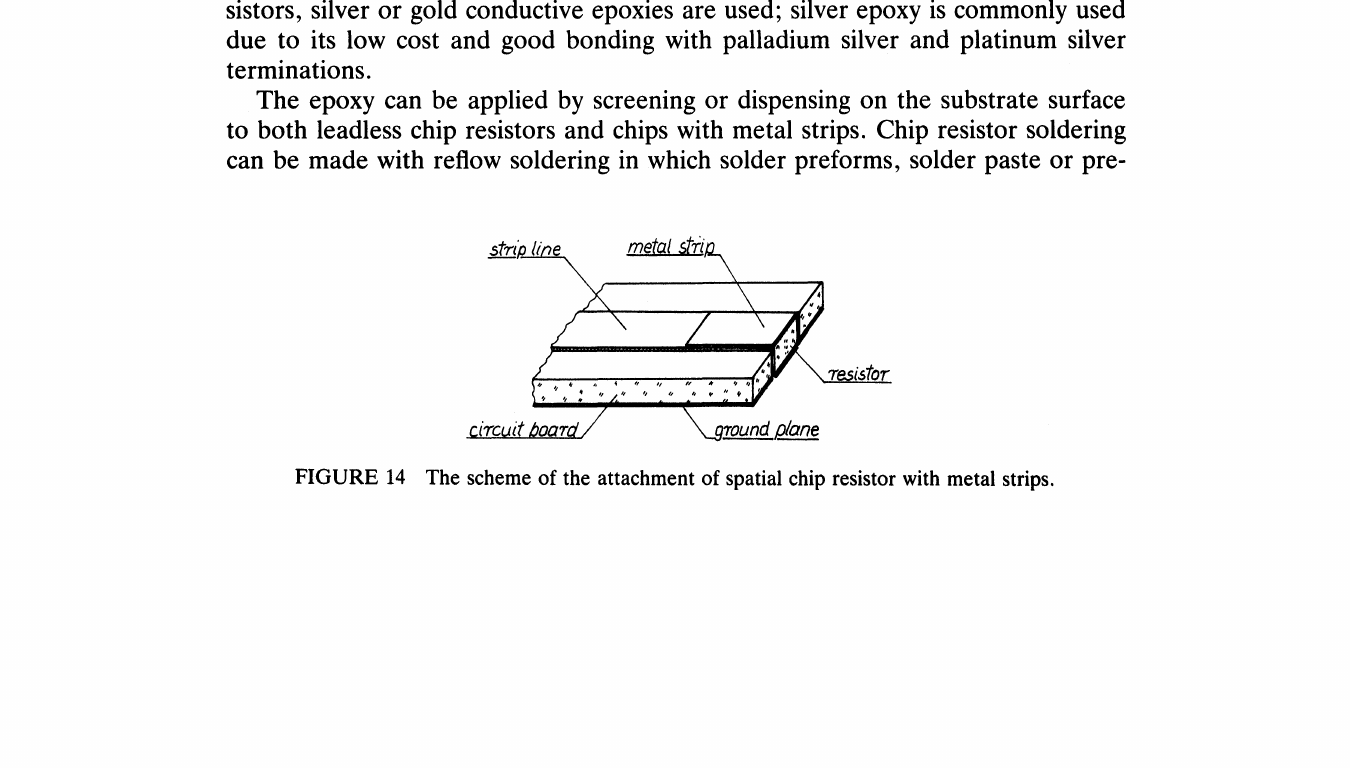
FIGURE 14 The scheme of the attachment of spatial chip resistor with metal